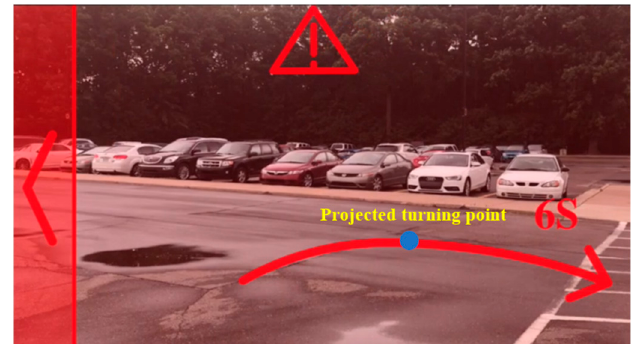
Figure 9. Example of scenario 3: Only the turning point could be projected in the warning window.